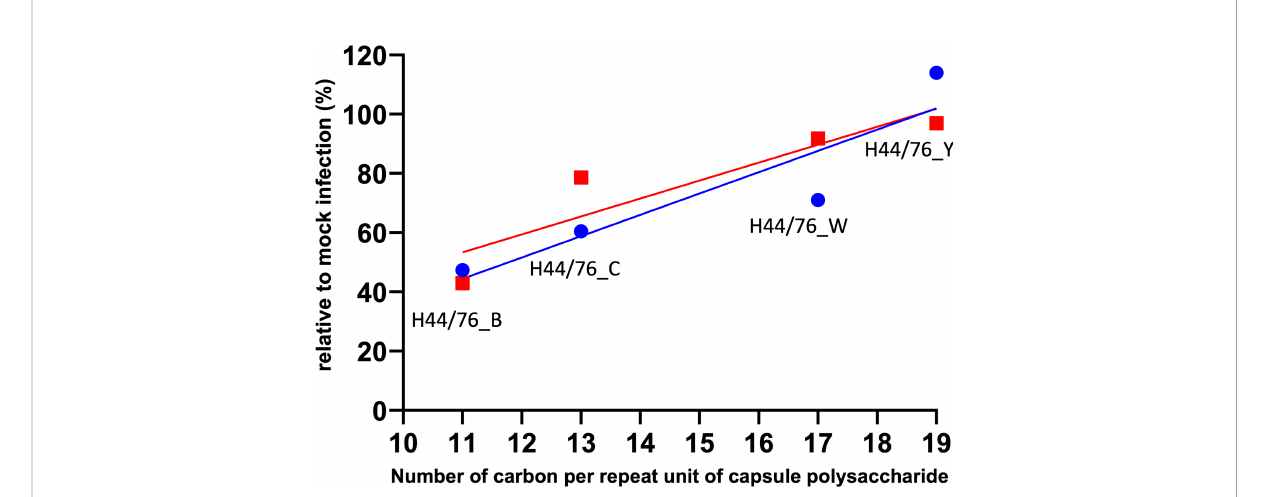
FIGURE 6 Relation between metabolic cost and meningococcal virulence in zebra fi sh embryos. Lines represent linear regression. Red: Zebra fi sh embryo survival after 96 hours post infection with either of the four isogenic capsule variants is the ratio between the number of embryos survived after meningococcal infection and after mock infection (r=0.9090). Blue: Integrated density of the green fl uorescence signal as a measure of the number of neutrophils in the area of interest after 24 hours post infection with either of the four isogenic capsule variants divided by that of mock infection; neutrophil count relative to mock-infected zebra fi sh embryos